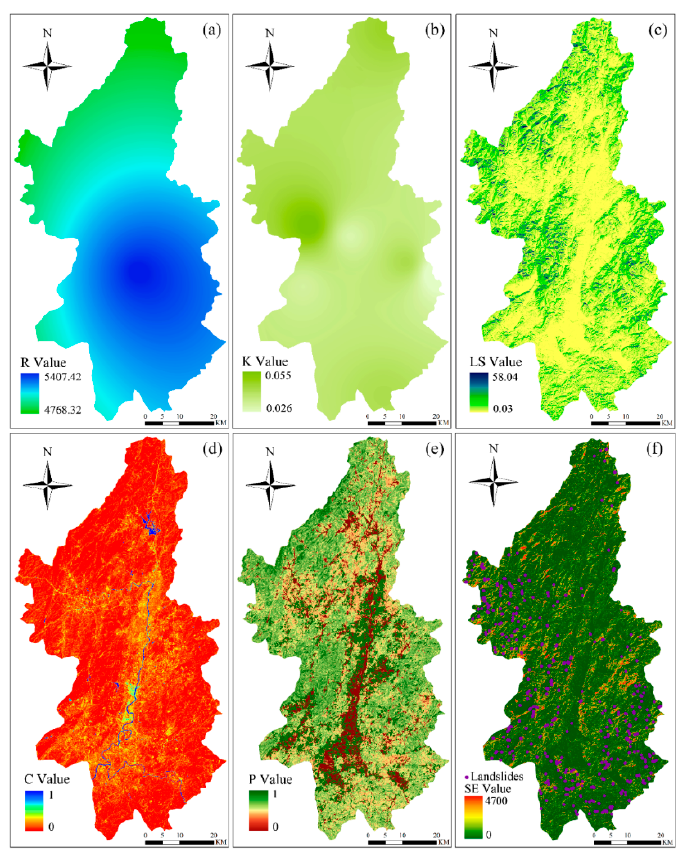
Figure 4. SE values and related factors with 30 m resolutions: ( a ) R value; ( b ) K value; ( c ) LS value; ( d ) C value; ( e ) P value; ( f ) SE value.